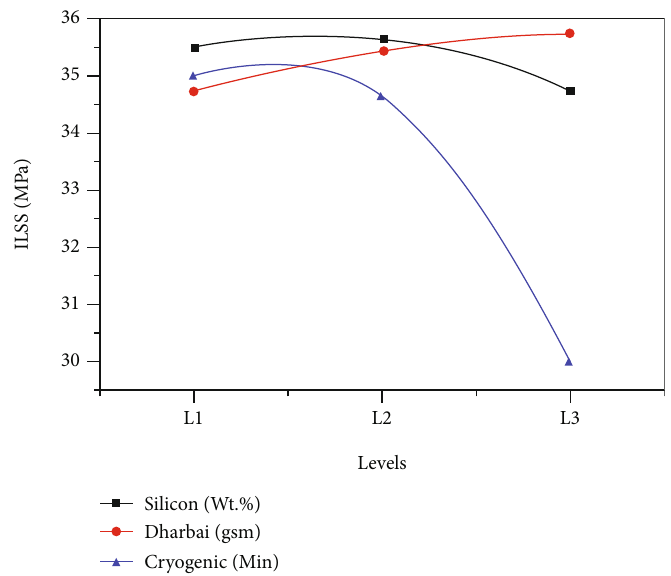
Figure 2: ILSS behaviour of nanocomposites under cryogenic environment.